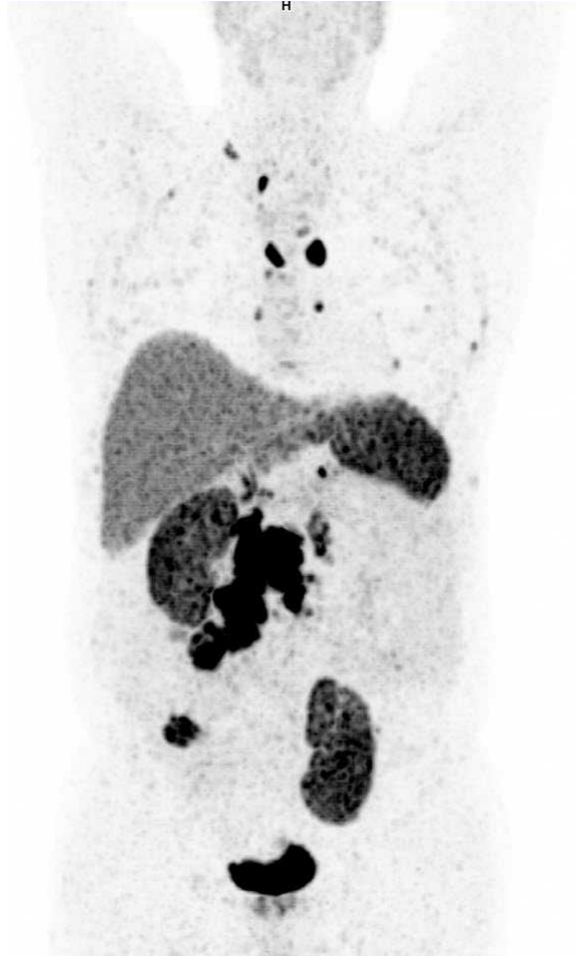
Figure 4. Imaging of a patient with incidentally discovered small intestinal NET. 68 Ga-DOTATOC-PET from a patient with disseminated incidentally discovered small intestinal NET in a seventy-